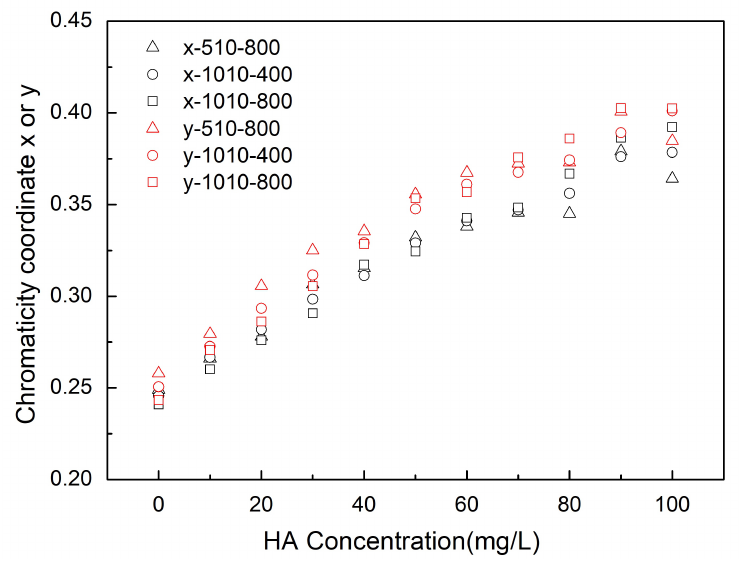
Figure 4. The xy chromatic diagram derived from RGB at different light illuminations (i.e., 510 and 1010 Lux) and different camera ISO (i.e., 400 and 800) of the dissolved humic acid at gradually increasing